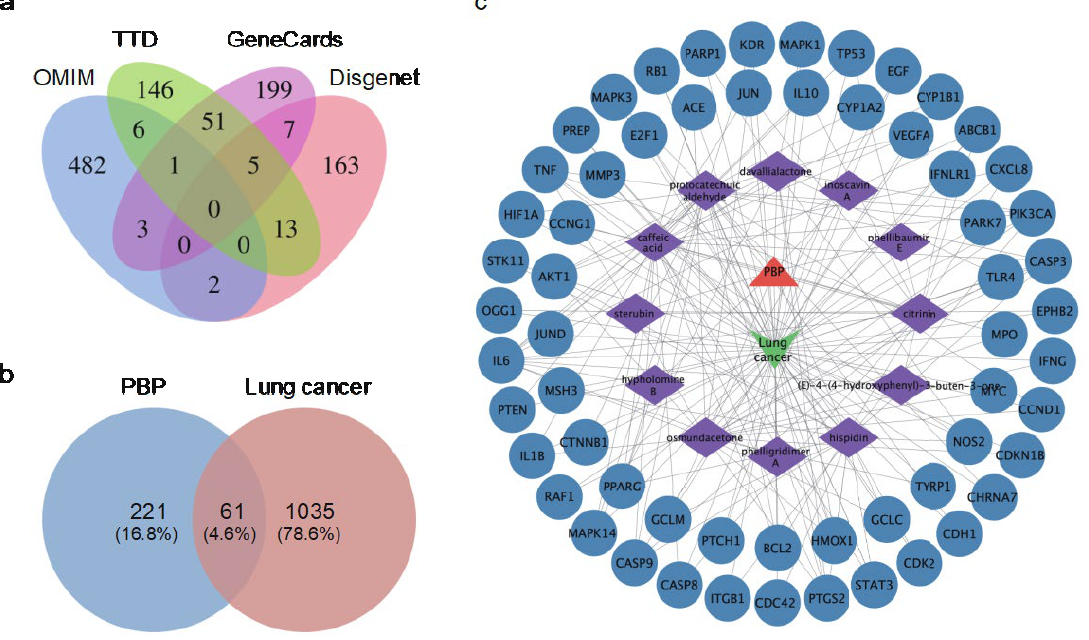
Figure 2. The targets of PBP treat lung cancer and the Components-Disease-Targets network. ( a ) Venn diagram of lung cancer targets; ( b ) Venn diagram of PBP treat lung cancer; ( c ) Drug-Components-Disease-Targets network. The orange triangle represents PBP. The green wedge represents lung cancer. The active substances in PBP are represented by the purple prisms. The targets are shown as blue circles.